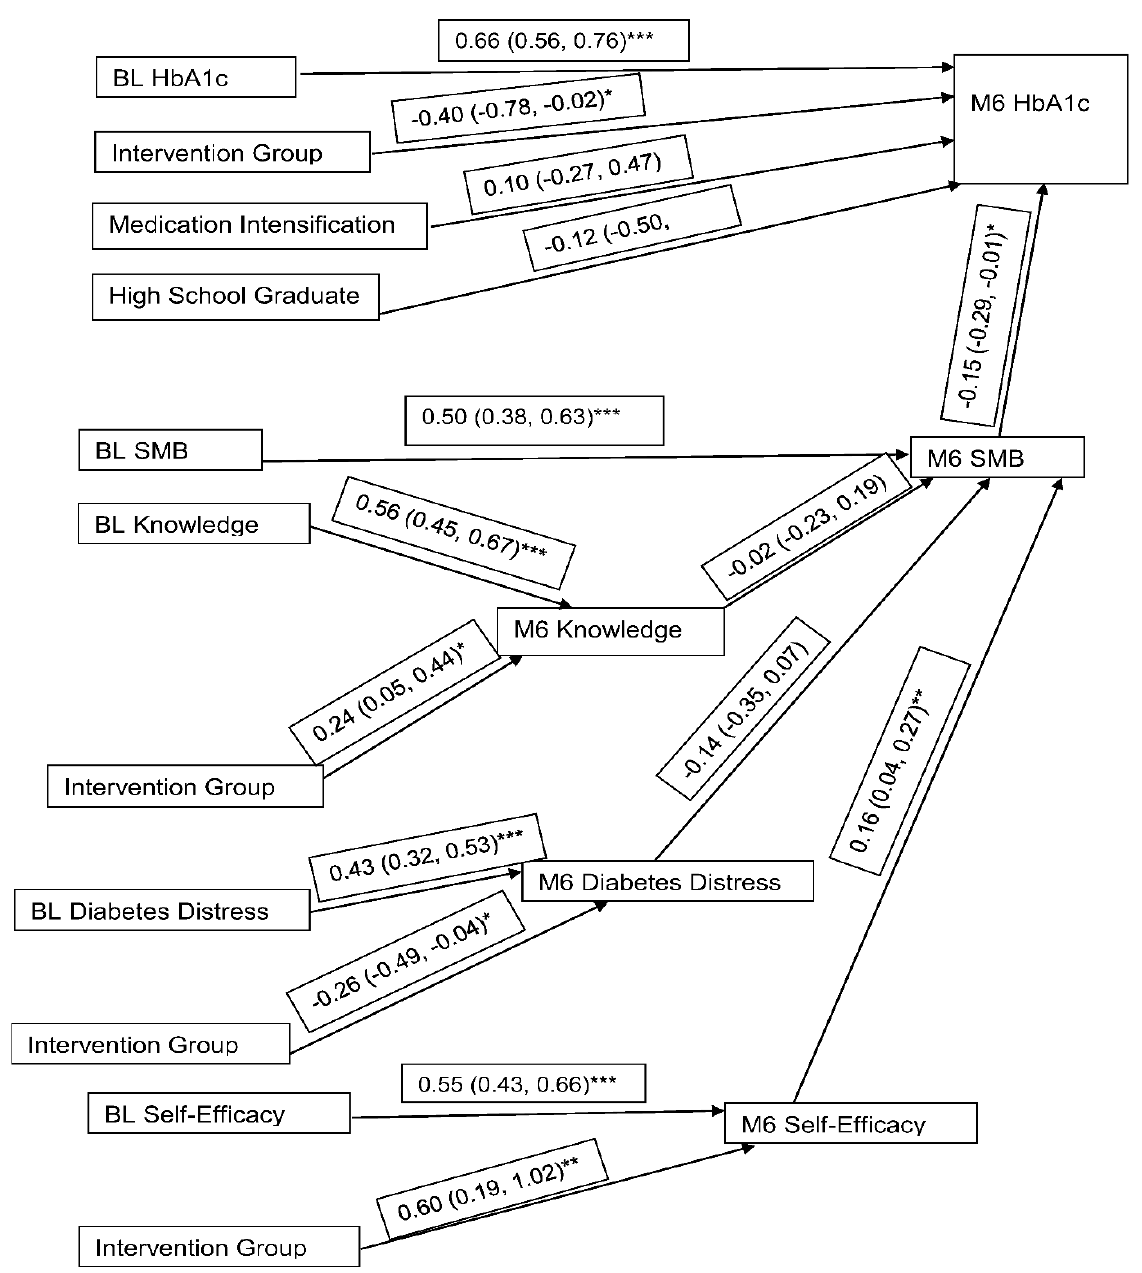
Figure 2. Path Analysis with Model Coefficients and Standard Errors. (* p < 0.01, ** p < 0.05, *** p < 0.001)